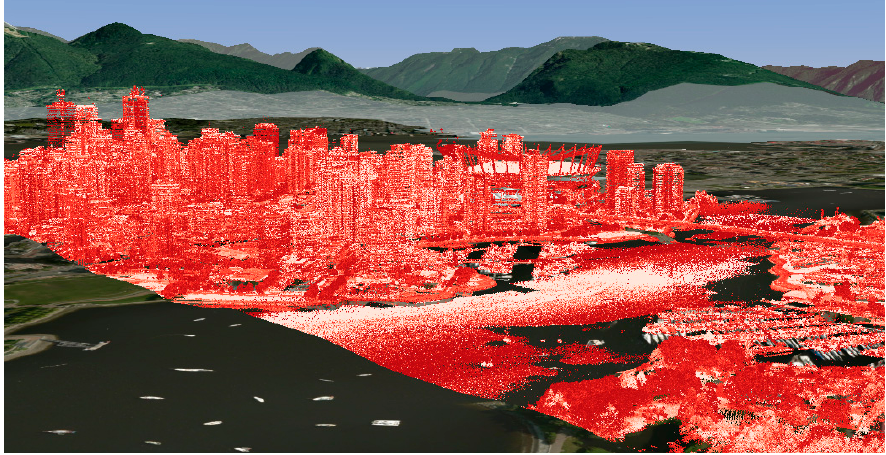
Figure 7. A LiDAR cloud point map superimposed over a Bing aerial view of North Vancouver.